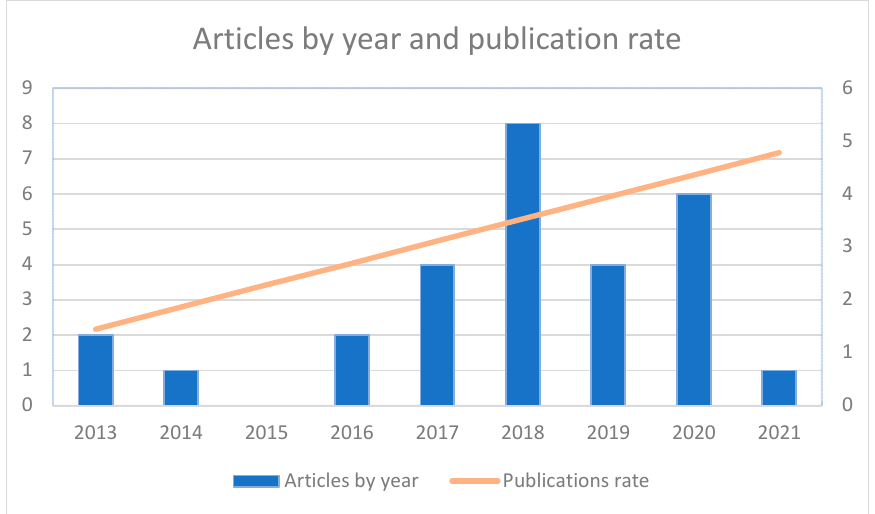
Figure 2. Articles by year and publication rate (calculated using RMS Lest Square Fit).